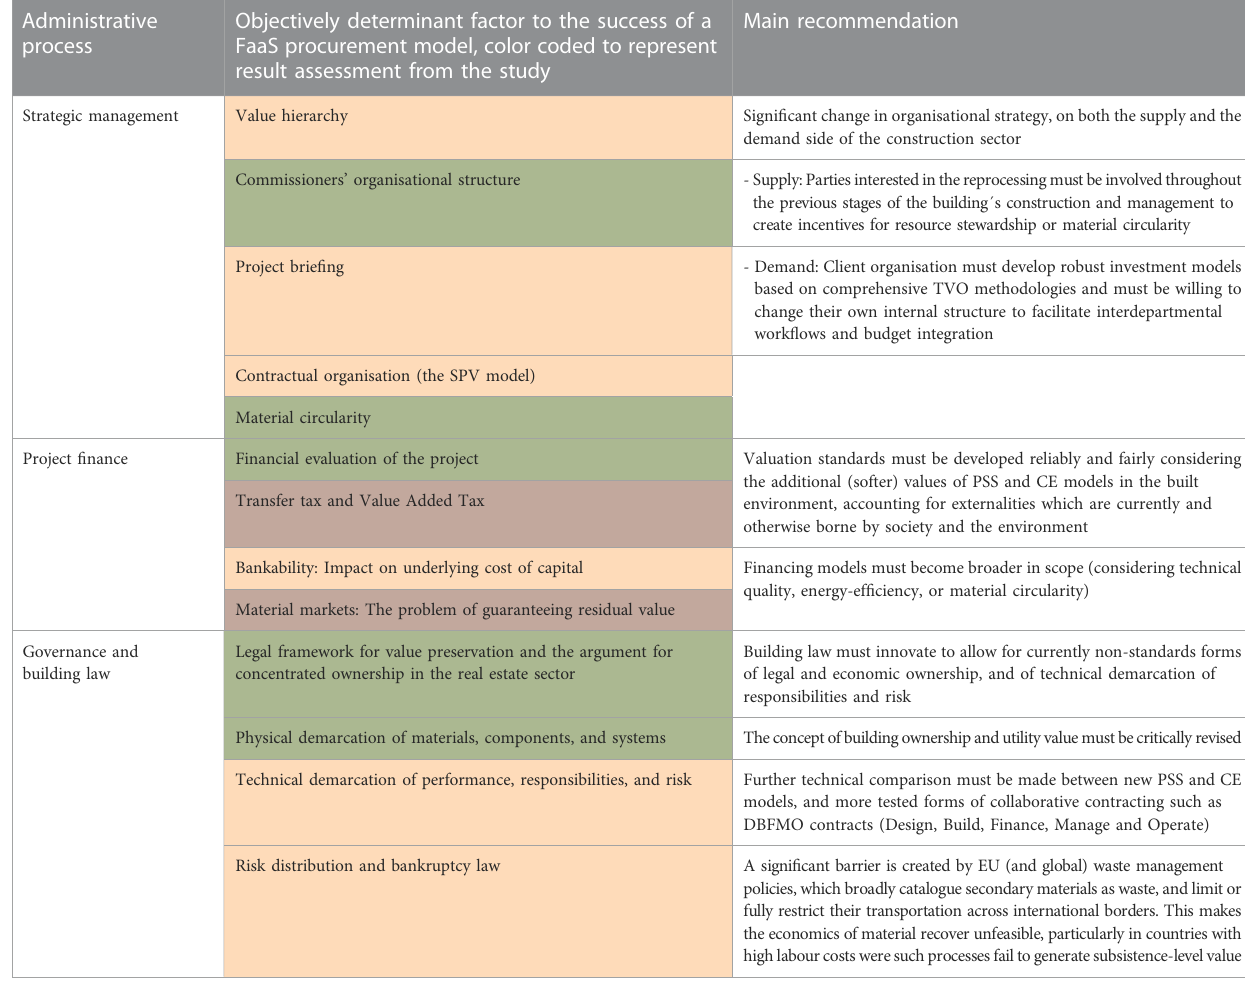
TABLE 3 Results summary from the perspective of the three disciplinary fi elds of study. Administrative